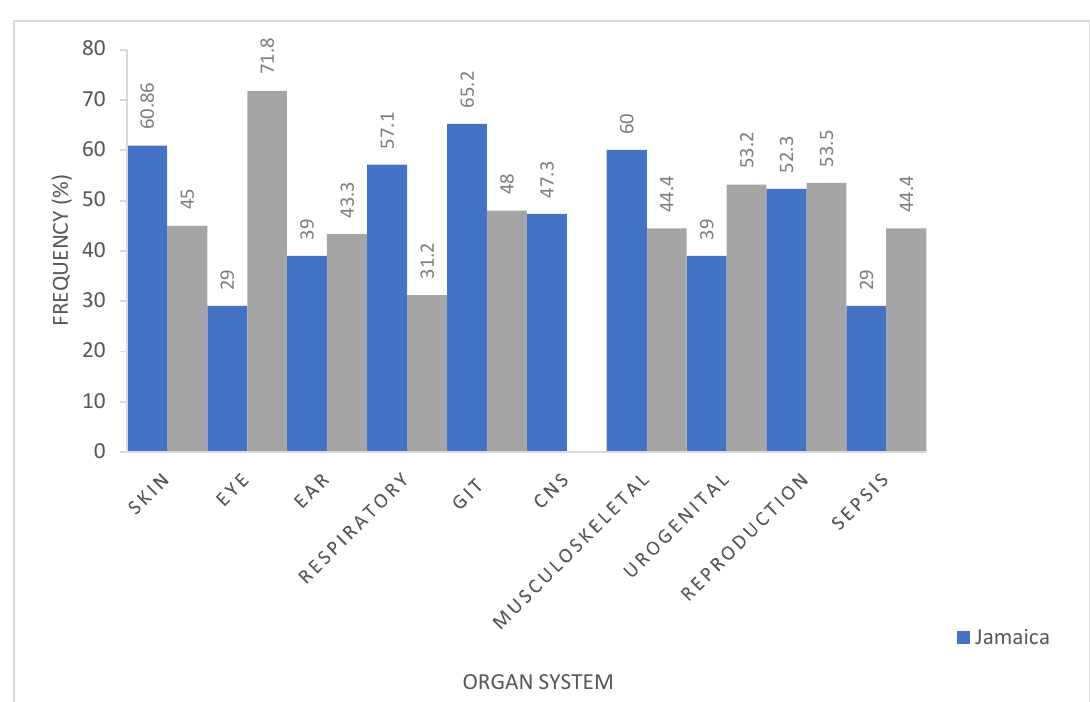
Figure 4. Comparison of the most common antimicrobials used for the different organ systems in veterinary practices in Jamaica vs. Trinidad .